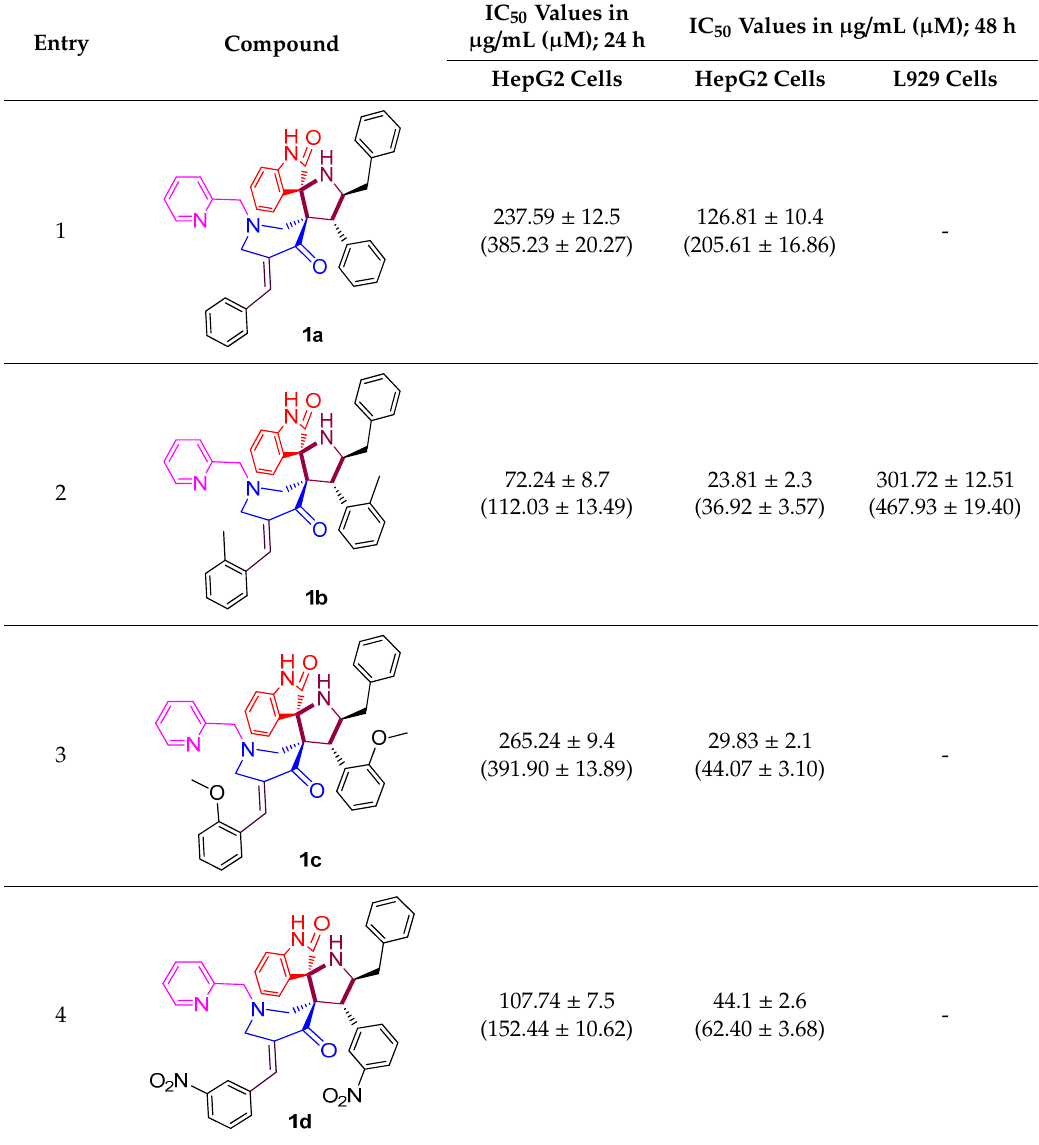
Table 1. Comparison of the IC 50 values of the tested compounds 1(a-h) against HepG2 cells over 24 and 48 h incubation periods.